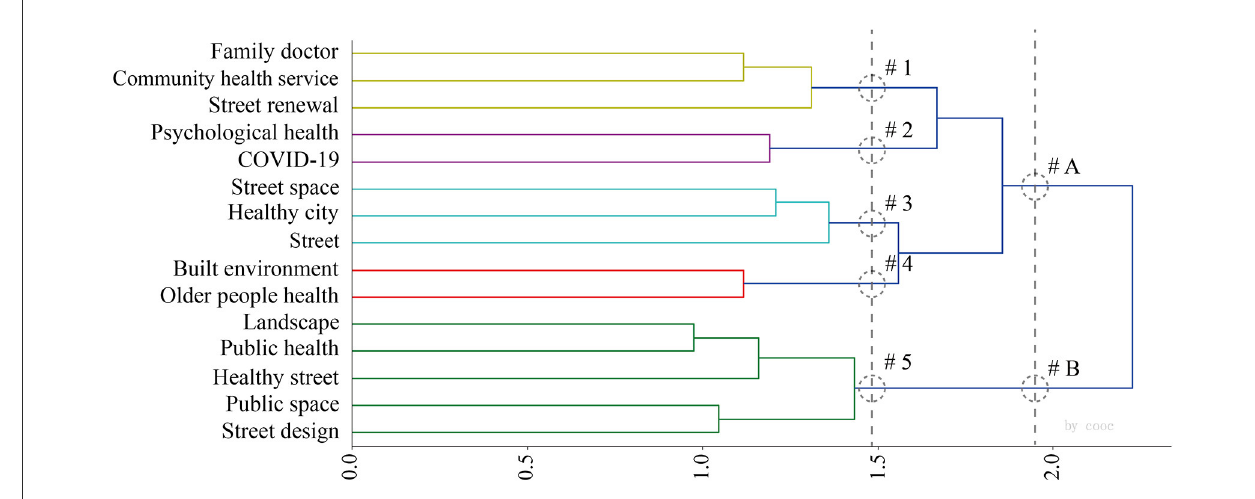
FIGURE10 Hierarchical cluster analysis dendrogram 2020–2022.